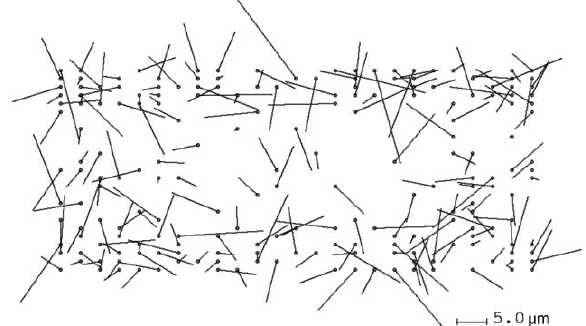
Figure 10: Superimposition of the image residuals of 37 orientations of data set 3, gridded in 25 x 25 cells